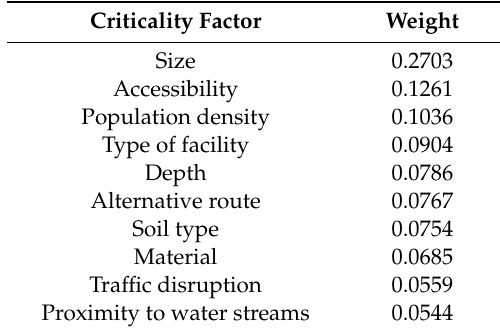
Table 4. Weights of criticality factors.